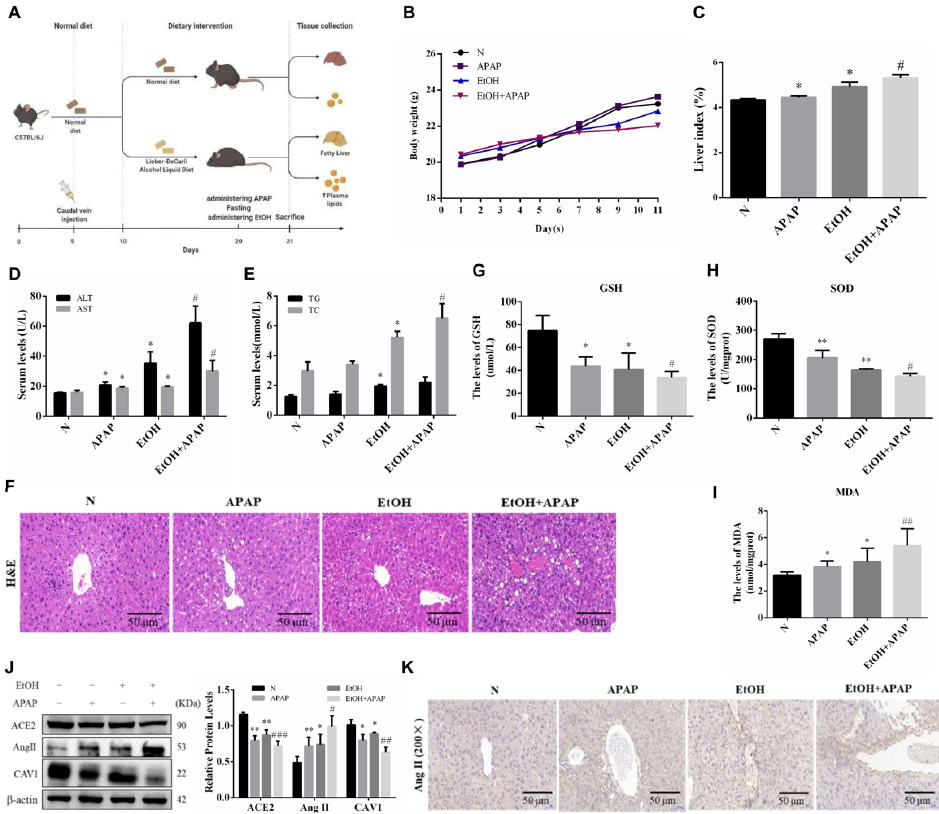
Figure 1. APAP aggravated liver injury in ethanol-induced AFLD mice; the protein expression of CAV1 and ACE2 were decreased while the Ang II was increased in APAP treated AFLD mice, with the oxidative stress levels increasing. Male C57BL/6J mice were fed an alcohol liquid diet or equivalent liquid control diet, while APAP (280 mg/kg) was given by gavage on the last day. ( A ) Animal experiment process. ( B ) The bodyweight of mice in each group. ( C ) The liver index of mice in each group. ( D ) The serum activity of ALT and AST. ( E ) The serum activity of TG and TC. ( F ) Representative images of hematoxylin and eosin staining results (Scale bar = 50 µ m). ( G ) Serum glutathione (GSH). ( H ) Liver superoxide dismutase (SOD) activity. ( I ) Malondialdehyde (MDA) levels. ( J ) Western blot analysis of the relative protein levels of CAV1, ACE2 and Ang II were measured in liver tissue. ( K ) Representative images of immunohistochemistry results of Ang II for liver tissue sections (Scale bar = 50 µ m). Data represent the mean ± SEM ( n = 8 mice). * p < 0.05 vs. N group; ** p < 0.01 vs. N group; # p < 0.05 and ## p < 0.01 vs. APAP group. ### p <